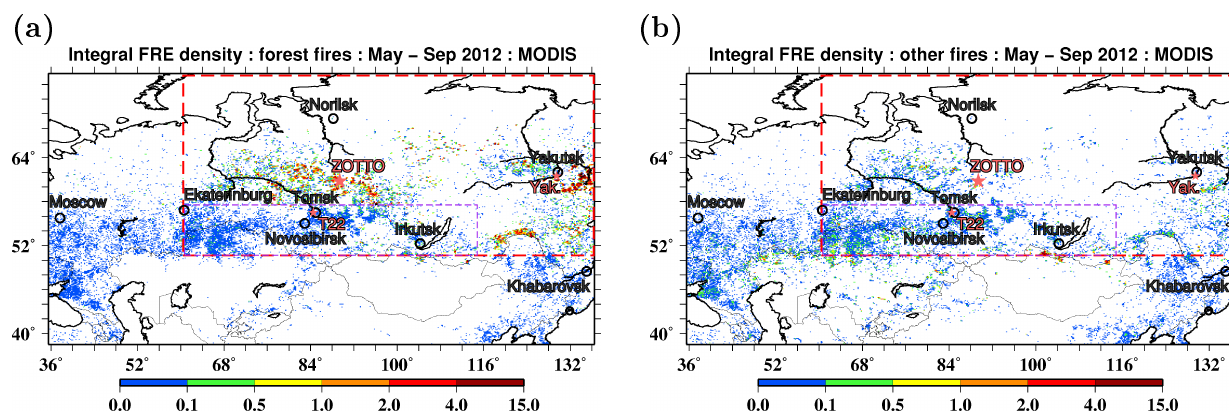
Figure 2. Spatial distributions of the mean fire radiative energy density (MJ m − 2 ) in the period from May to September 2012 for (a) forest fires and (b) other vegetation fires. The distributions with a spatial resolution of 0 . 2 ◦ × 0 . 1 ◦ were derived from the MODIS FRP data and are shown for the territories covered by a Siberian domain in the CHIMERE model. Red dashed rectangles depict the study region, and short purple dashes indicate a supplementary subregion discussed in Sect. 3.1. Pink asterisks indicate the locations of the ZOTTO site and the two AERONET sites, Tomsk-22 (T22) and Yakutsk (Yak.).